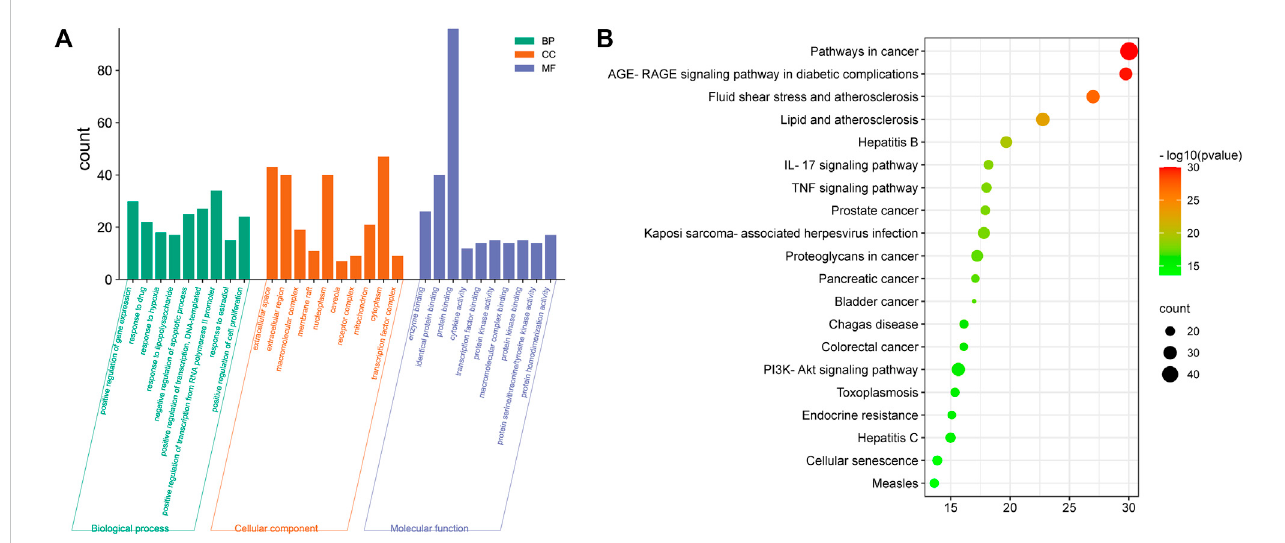
FIGURE 3 Functional enrichment analysis of targets. (A) GO enrichment analysis and (B) KEGG pathway enrichment analysis of SH-cisplatin-induced AKI.